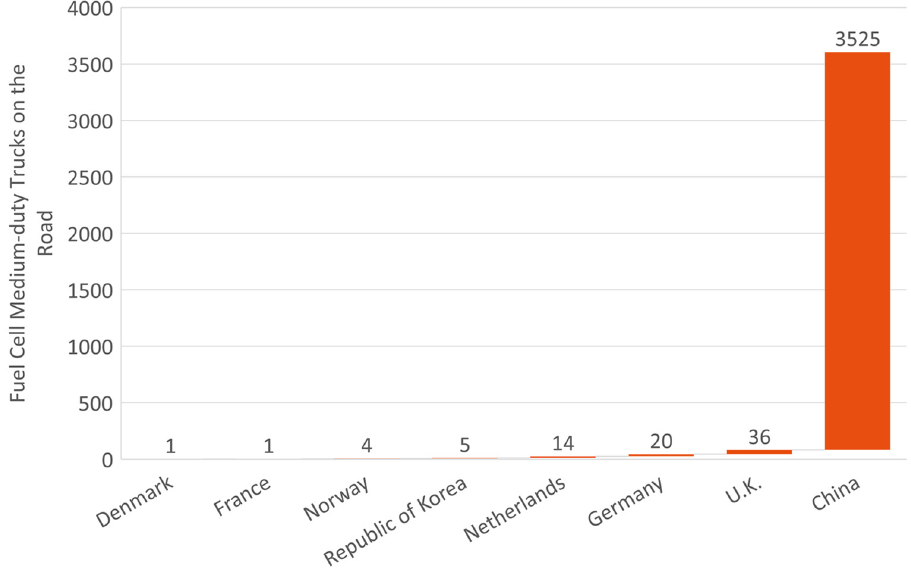
Figure 5. Waterfalldiagramshowingthebreakdownoffuelcellmedium-dutytrucks(MDFCTs) Figure 5. Waterfall diagram showing the breakdown of fuel cell medium-duty trucks (MD FCTs) worldwide.